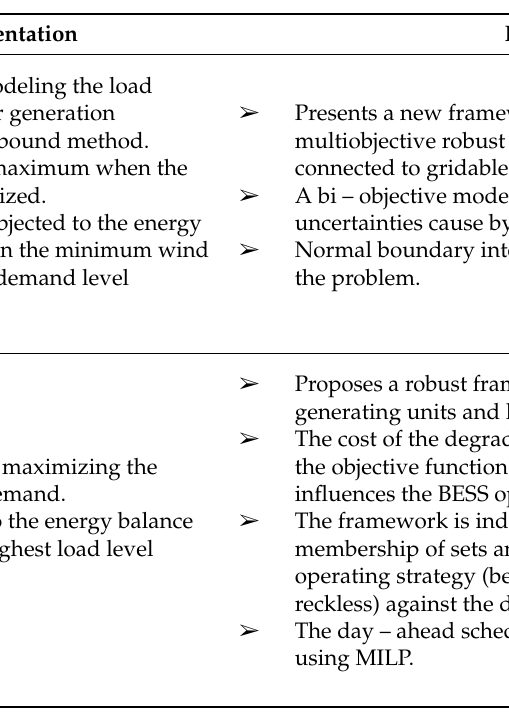
Table 16. Studies In Which IGDT Method Is